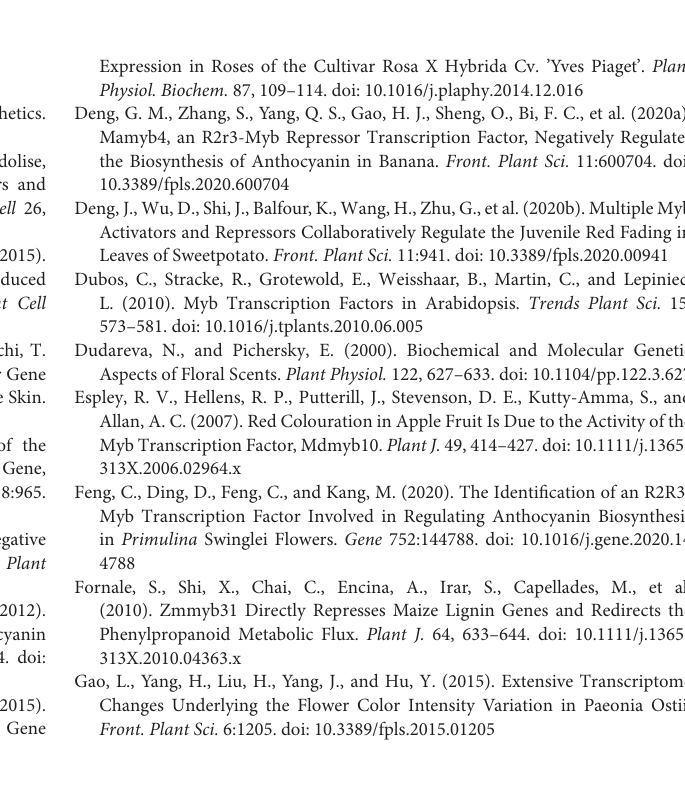
Supplementary Figure 1 | The sequences of LvMYB5 . Supplementary Figure 2 | Expression analysis of LvMYB1 . (A) Transient overexpression of LvMYB1 in Nicotiana benthamiana leaf cells. (B) Extraction of total anthocyanins from Nicotiana benthamiana leaves in the transient overexpression experiment. (C) Quantification of anthocyanin content in Nicotiana benthamiana leaves infiltrated with the empty vector or 35S: LvMYB1. (D) Expression levels of anthocyanin biosynthesis structural genes in Nicotiana benthamiana leaves. Supplementary Figure 3 | Transient overexpression experiments on lily petals. (A) Before agroinfiltration, lily bud (about 10 cm) and the outer petals, which were green and had just begun to color. (B) After agroinfiltration (1 week later), the lily petals infiltrated with the empty vector became curling and slightly faded. Red box: the region of the petals infected by agrobacteria; Black arrow: uninfected petal region. Supplementary Figure 4 | Multiple-sequence alignments of LvMYB5 with MYB related-anthocyanin biosynthesis TFs in other lily cultivars. Supplementary Table 1 | The sequences of oligonucleotide primers used in this